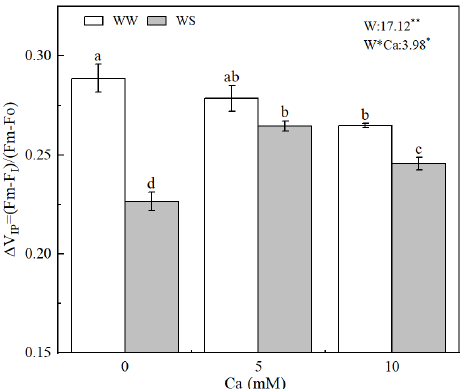
Figure 6. The effects of well water (WW), water stress (WS) and different calcium (Ca) concentrations on relative amplitude of the I–P phase, △ V IP = (Fm − F I )/(Fm − Fo). Except for DIo/CS, water stress significantly reduced the other phenomenological en- ergy fluxes (ETo/CS, ABS/CS, and TRo/CS, Figure 7). Compared with 0 mM Ca 2+ , ETo/CS, ABS/CS, and TRo/CS were decreased by 10 mM Ca 2+ in water stress. Water significantly affected phenomenological energy fluxes (ETo/CS, ABS/CS, TRo/CS, and DIo/CS). Addi- tionally, the interaction of water and calcium significantly influenced ABS/CS, TRo/CS, and DIo/CS. A significant decrease in RC/CS was observed in water stress compared with well water. The ABS/RC, TRo/RC, and DIo/RC were increased in water stress. The specific energy fluxes showed almost no differences among Ca concentrations under well-watered treatments. Ca significantly influenced specific energy fluxes (ABS/RC, TRo/RC, ETo/RC, and DIo/RC). Moreover, the interaction of water and calcium significantly influenced TRo/RC, ETo/RC, and DIo/RC. ABS/RC, TRo/RC, and ETo/RC showed a similar trend un- der water stress, and 10 mM Ca 2+ decreased ABS/RC, TRo/RC, and ETo/RC under water stress compared with 0 mM Ca 2+ and 5 mM Ca 2+ . The quantum yields and efficiency were significantly decreased by water stress. Moreover, δ Ro was significantly affected by the interaction of water and calcium. The ψ Po, δ Ro, and φ Ro were reduced with the increas- ing in Ca concentration in well-watered treatments. In contrast to well water, the applica- tion of exogenous calcium increased the ψ Po, δ Ro, and φ Ro under water stress, which was much more pronounced in 5 mM Ca 2+ . Exogenous calcium, however, had no effect on ψ Eo, φ Po, and φ Eo in both water conditions. Water significantly affected PI ABS and PI total , and obviously reduced PI ABS and PI total ( p < 0.05, Figure 8). Although exogenous calcium did not significantly affect PI ABS water conditions (Figure 8A), 5 mM Ca 2+ significantly in- creased PI total under water stress compared with 0 mM Ca 2+ and 10 mM Ca 2+ (Figure 8B). Calcium and the interaction of water and calcium significantly influenced PI total .